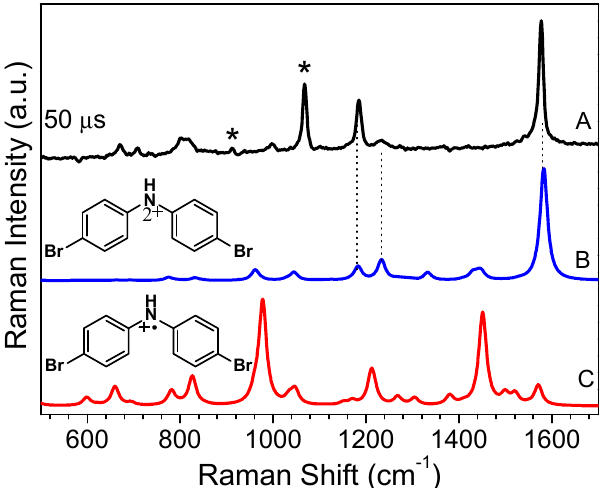
Figure 3. Comparison between the ns-TR 3 spectra of 1 at 50 µs achieved in 1:1 MeCN:1 mM HClO 4 solution (pump 266 nm, probe 368.9 nm) ( A ) and the density function theory (DFT)-calculated Raman spectra of intermediate 3 ( C ) and 4 ( B ). The * symbols result from the solvent subtraction artifacts.